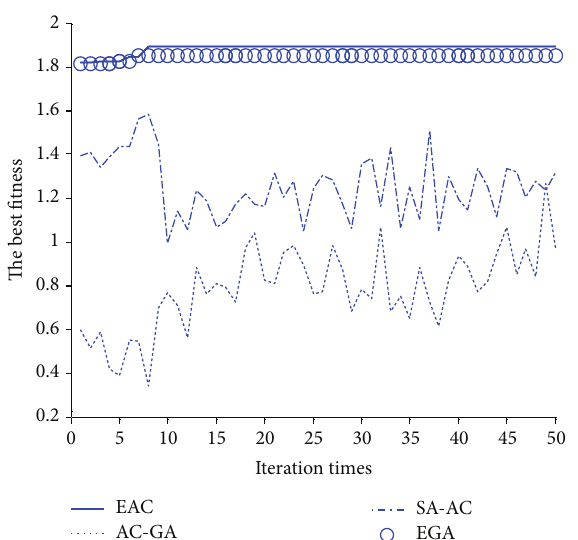
Figure 19: Convergence curves about the optimal fitness running 50 times on map II.